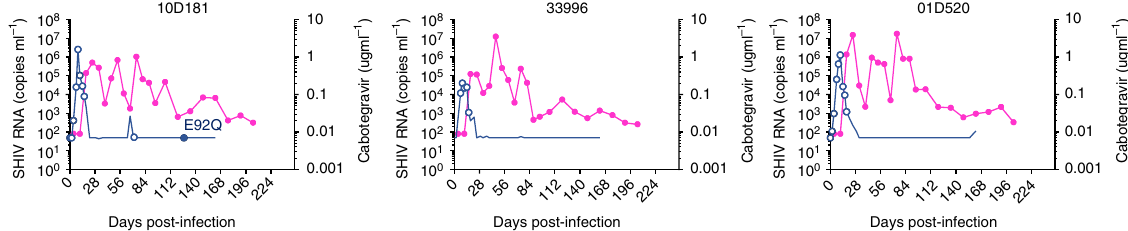
Fig. 4 Integrase mutations identi fi ed in viruses from vaginal fl uids. The magenta line indicates the concentrations of cabotegravir and the blue line SHIV RNA levels. Circles denote time points that were successfully ampli fi ed and genotyped. Closed circles denote time points with integrase mutations,